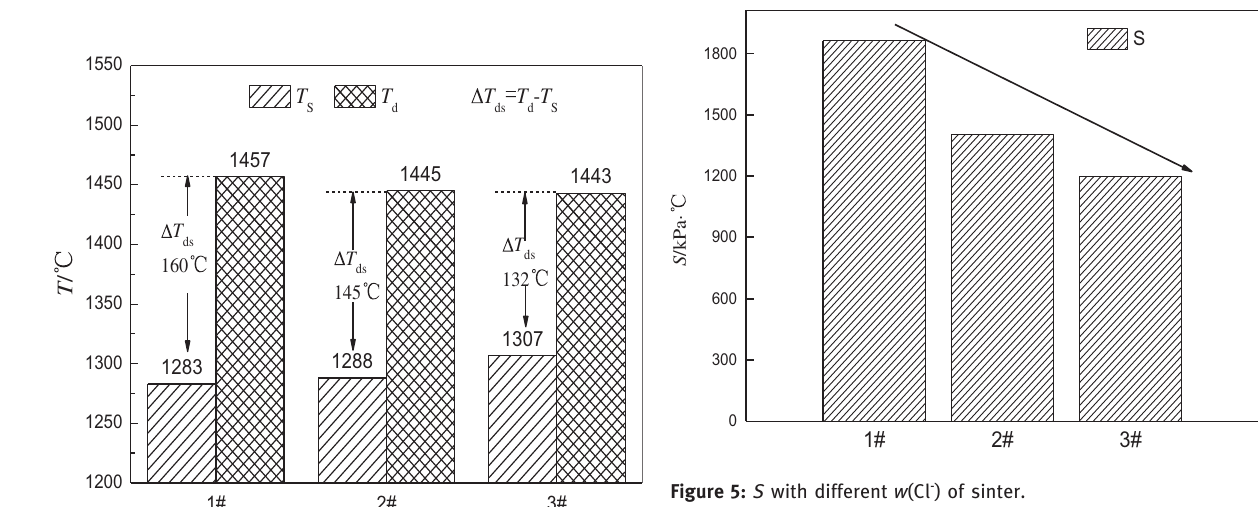
Figure 5: S with different w (Cl - ) of